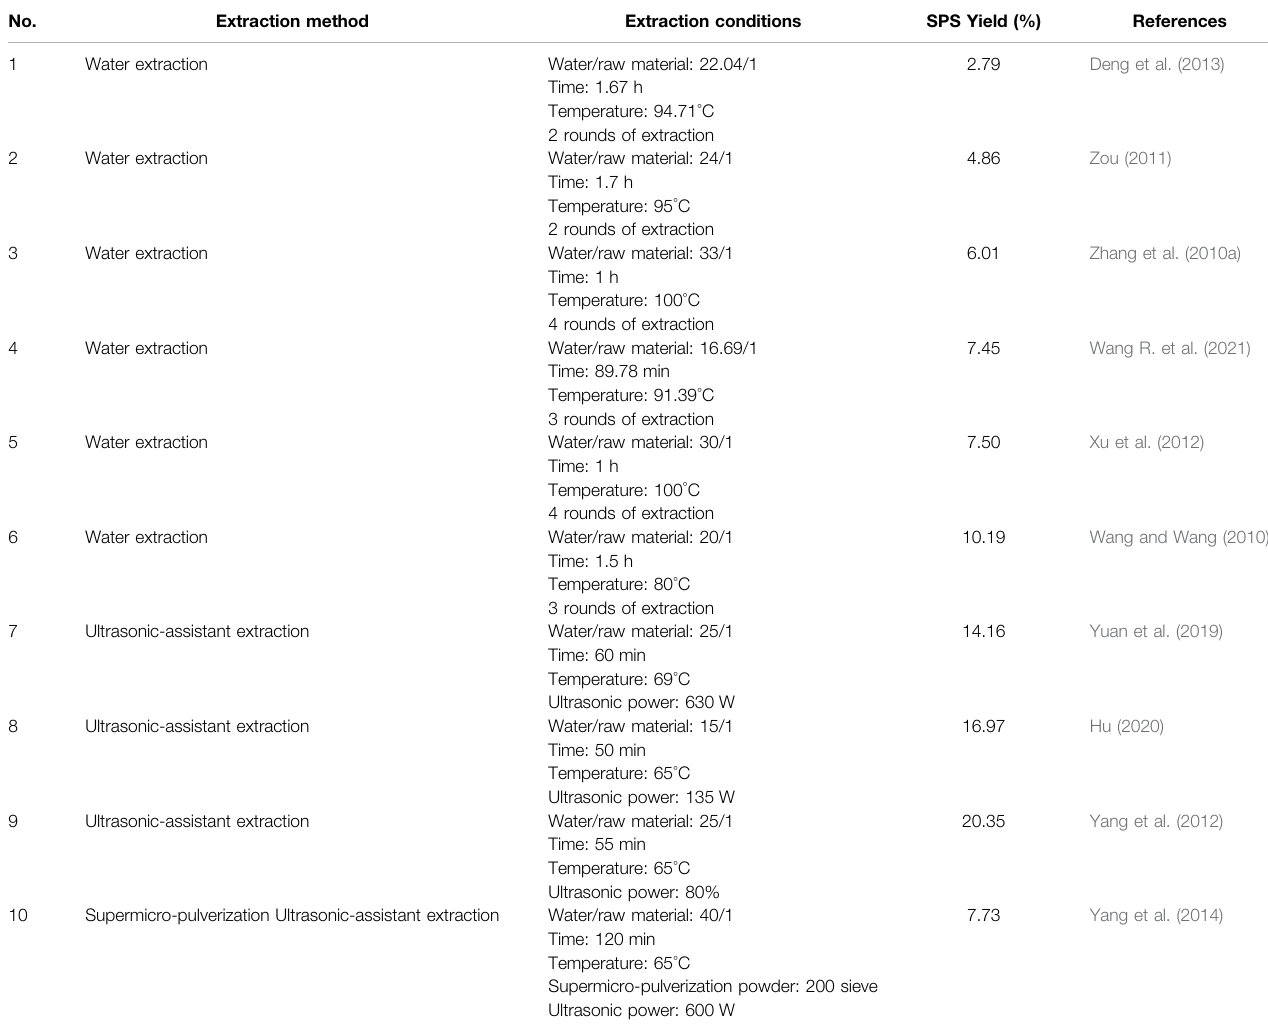
TABLE 1 | Detailed information of various methods for SPS extraction.